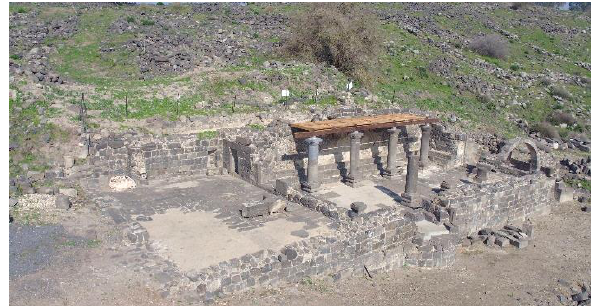
Figure 7. Dir Aziz synagogue, type F. (Photo: M. Peleg, 2018 ©